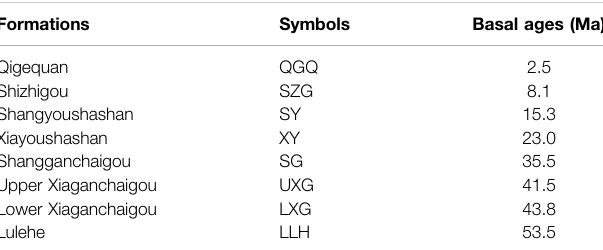
Formations Symbols Basal ages